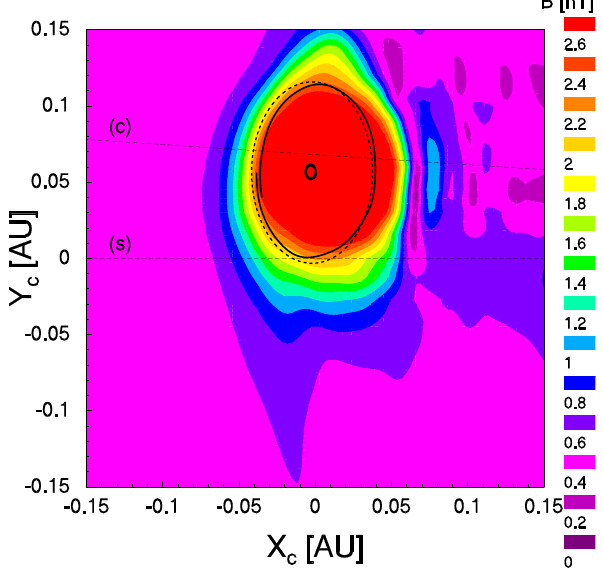
Fig. 8. Cross section through the flux rope around the point A for a 20 ◦ inclined flux rope. Outline is similar to Fig.